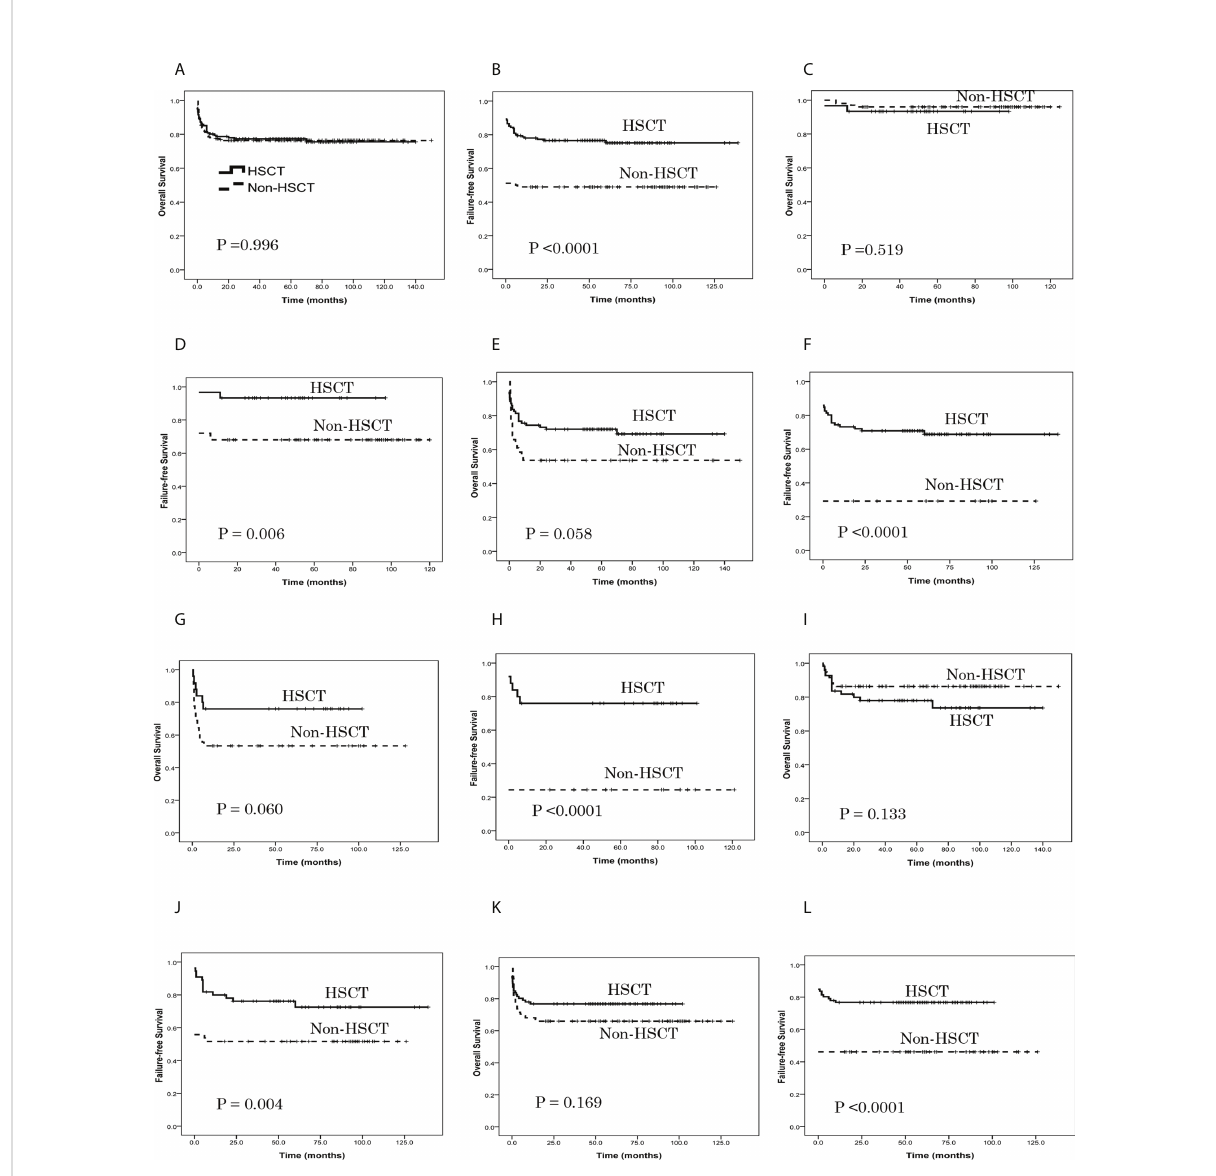
FIGURE 2 Patient overall survival (OS) and failure-free survival (FFS), as assessed using Kaplan-Meier analysis. (A) The estimated OS at 6 years was 75.5% ± 3.9% in the HSCT group and 76.3% ± 3.1% in the non-HSCT group ( P = 0.996). (B) The estimated FFS at 6 years was 75.2% ± 3.8% in the HSCT group and 48.9% ± 3.7% in the non-HSCT group ( P < 0.0001). (C) For patients aged ≤ 14 years, the estimated OS at 6 years was 93.3% ± 4.6% in the HSCT group and 96.0% ± 2.0% in the non-HSCT group ( P = 0.519). (D) For patients aged ≤ 14 years, the estimated FFS at 6 years was 93.3% ± 4.6% in the HSCT group and 68.0% ± 4.7% in the non-HSCT group ( P = 0.006). (E) For patients aged 15 – 39 years, the estimated OS at 6 years was 69.2% ± 5.4% in the HSCT group and 53.7% ± 7.8% in the non-HSCT group ( P = 0.058). (F) For patients aged 15 – 39 years, the estimated FFS at 6 years was 68.6% ± 5.2% in the HSCT group and 29.3% ± 7.1% in the non-HSCT group ( P < 0.0001). (G) For patients aged ≥ 40 years, the estimated OS at 6 years was 76.0% ± 8.5% in the HSCT group and 53.3% ± 7.4% in the non-HSCT group ( P = 0.060). (H) For patients aged ≥ 40 years, the estimated FFS at 6 years was 76.0% ± 8.5% in the HSCT group and 24.4% ± 6.4% in the non-HSCT group ( P < 0.0001). (I) For grade 1- 2 infection, the estimated OS at 6 years was 73.6% ± 6.8% in the HSCT group and 86.3% ± 3.5% in the non-HSCT group ( P = 0.133). (J) For grade 1-2 infection, the estimated FFS at 6 years was 72.5% ± 6.5% in the HSCT group and 51.6% ± 5.1% in the non-HSCT group ( P = 0.004). (K) For grade 3-4 infection, the estimated OS at 6 years was 76.7% ± 4.6% in the HSCT group and 65.9% ± 5.0% in the non-HSCT group ( P = 0.169). (L) For grade 3-4 infection, the estimated FFS at 6 years was 76.7% ± 4.6% in the HSCT group and 46.2% ± 5.2% in the non-HSCT group ( P <